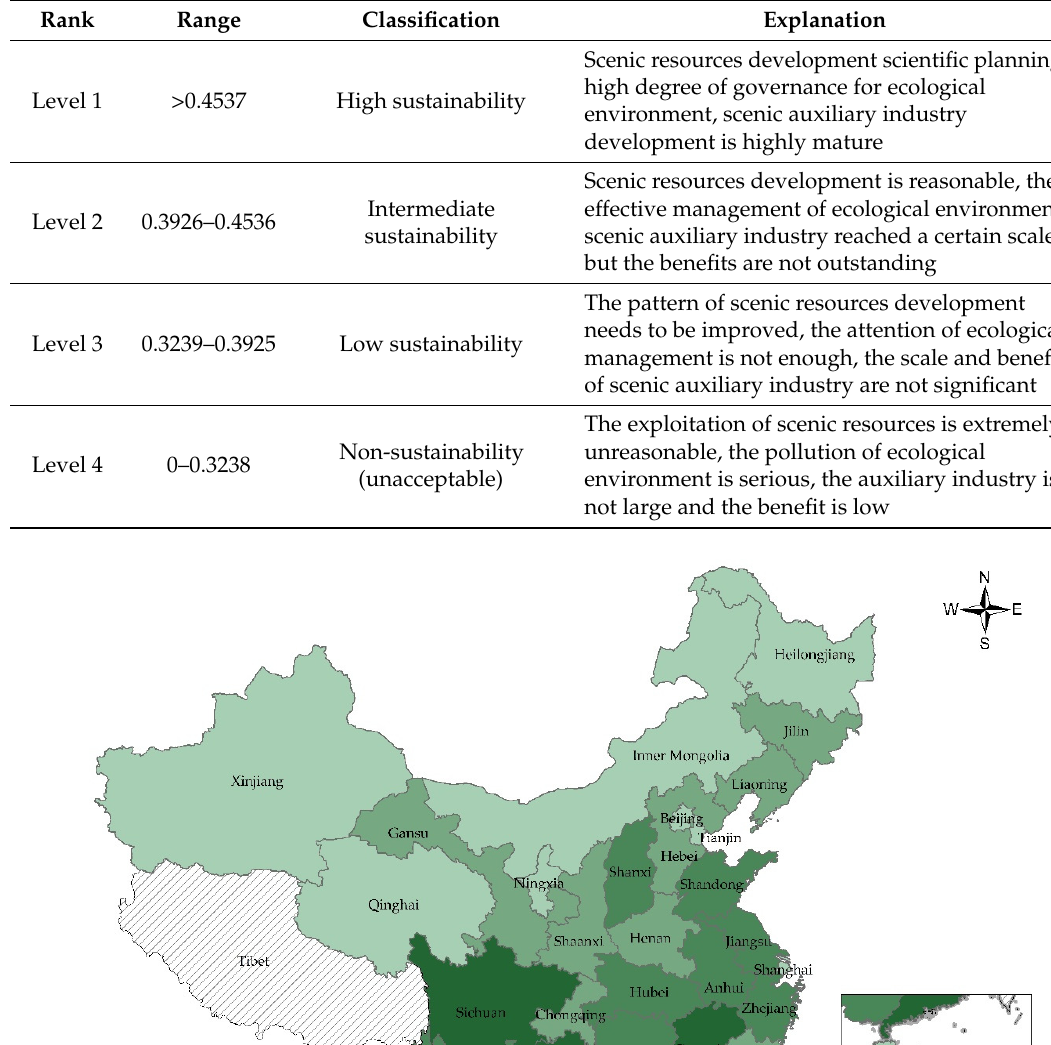
Table 8. The division basis and explanation of the sustainable development of scenic spots.